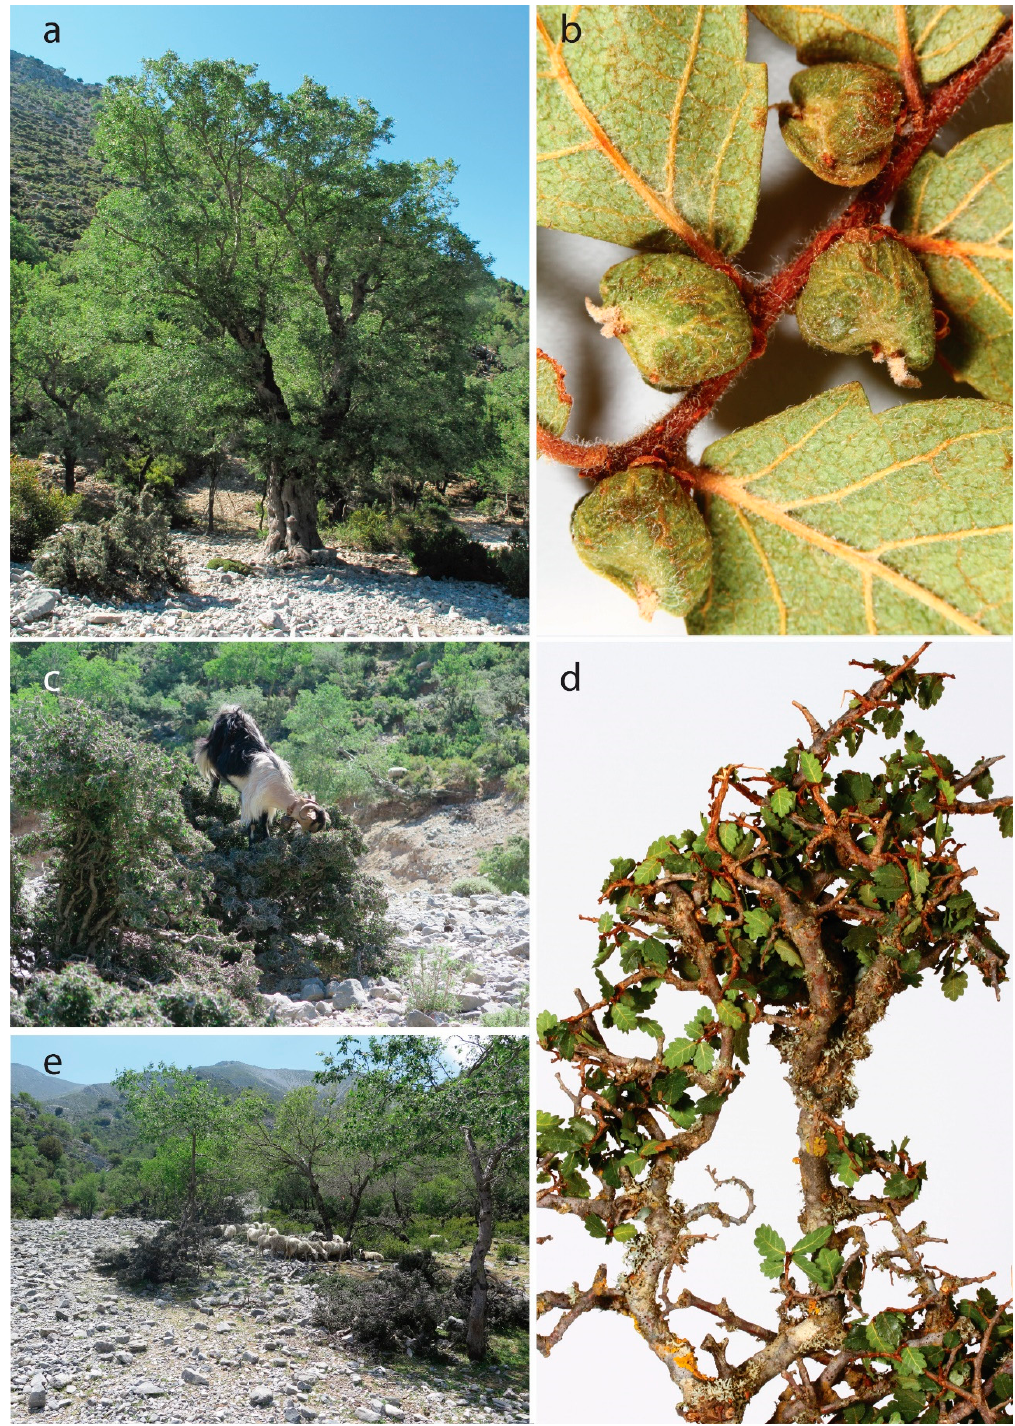
Figure 3. Zelkova abelicea (Ulmaceae), an example of an endangered tree species endemic to the Mediterranean island of Crete (Greece). Only large trees can produce fruits ( a , b ). However, the majority of fruit is empty, which is probably due to unfavorable climatic conditions such as pronounced and recurrent droughts. The overwhelming majority of individuals, however, are dwarfed and nonfruiting due to overbrowsing by goats ( c , d ). The regeneration of populations via seedlings is nearly impossible due to the overgrazing, trampling and soil erosion caused by omnipresent large caprine and ovine flocks ( e ). Pictures: G. Kozlowski ( a ), H-R Siegel ( b , d ), L. Fazan ( c , e ).